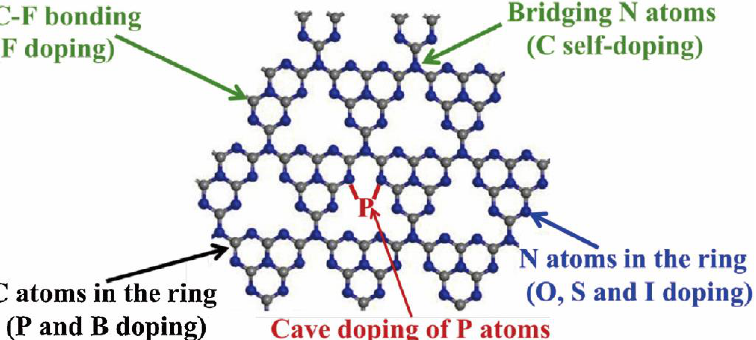
Figure 8. Schematic illustration of the non − metal doping of the g − C 3 N 4 framework [38]. Copyright 2017, Elsevier.